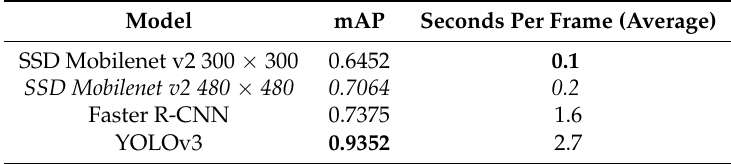
Table 4. Comparison of mean average precision in single-class object detection and single image frame processing time on on-board computer (bold is best, italic is final